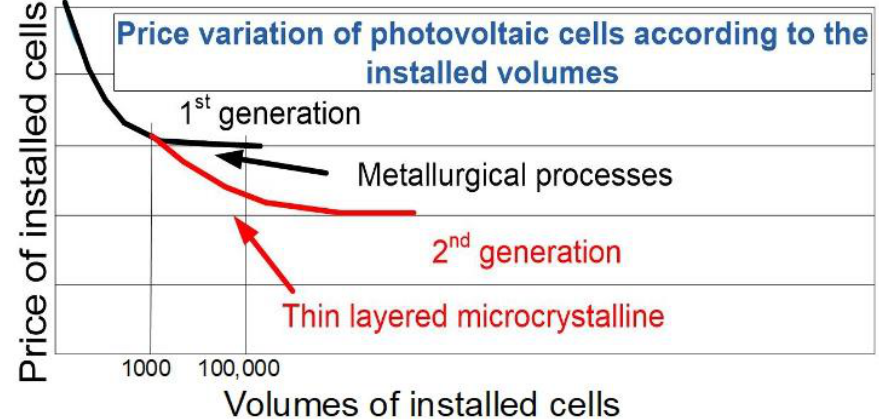
Figure 2. Cost reduction for second generation photovoltaic (PV): the low-cost metallurgical processes contribute to the realization of more cells.